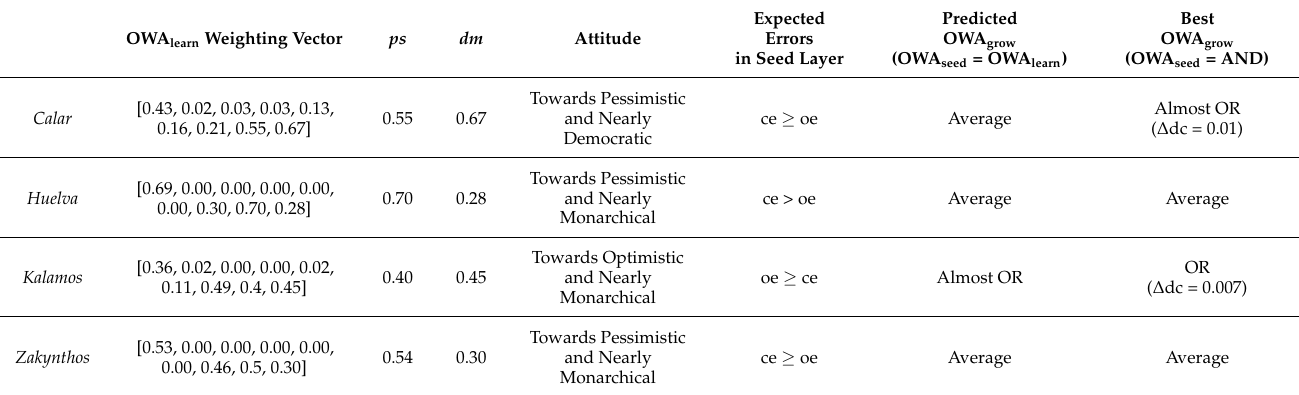
Table 5. Weighting vectors of the OWA learn in each site, its degrees of pessimism ps and democracy dm , the correspon- dent attitude expressed linguistically, the expected type of error in the seed layer generated by OWA learn , the predicted OWA grow based on the heuristic rules in (11) and the best performing OWA grow that has been assessed based on the validation